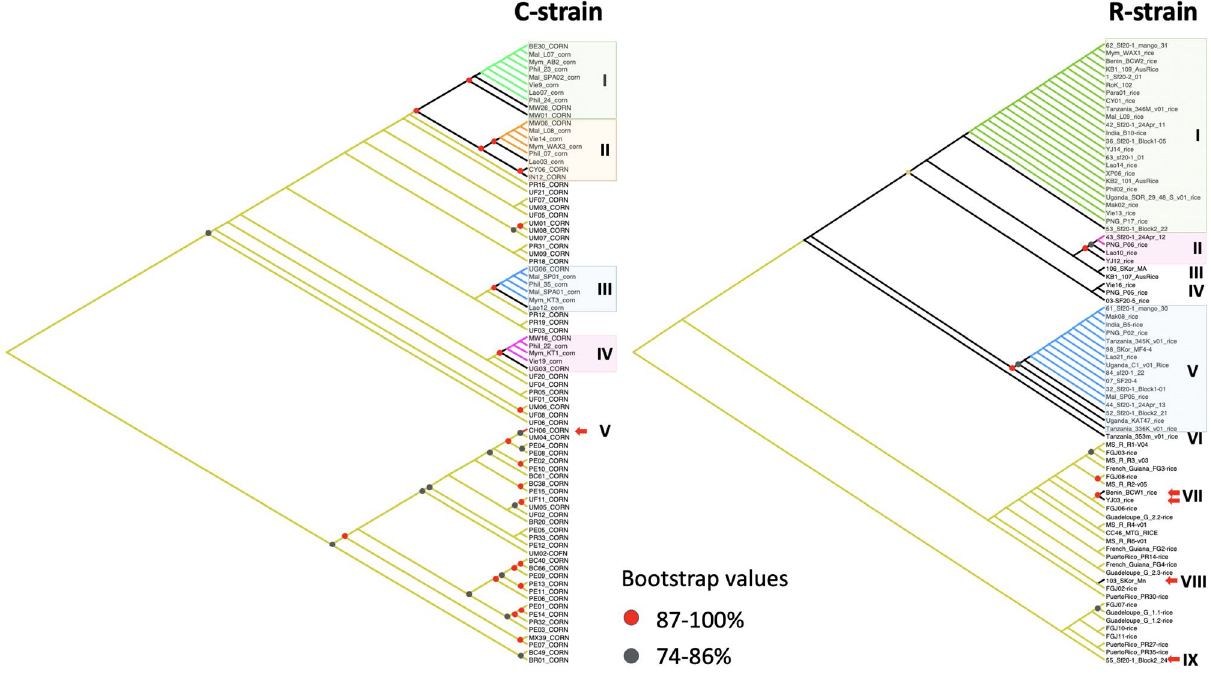
Figure 1. Maximum Likelihood cladograms of unique Spodoptera frugiperda C-strain and R-strain partial mitochondrial genomes based on concatenation of the 13 PCGs (11,393 bp) using IQ-Tree with 1000 UFBoot replications. Individuals in clades I, II, III, and IV (C-strain) and in Clades I, II, V (R-strain) that are in the same colour scheme (i.e., green, orange, blue, or pinks) shared 100% nucleotide identity. Mitogenome haplotypes from native individuals for both C- and R-strains are in khaki green colour. Red and dark grey dots at branch nodes represent bootstrap values of 87–100% and 74–86%, respectively. Bootstrap values < 74% are not shown. Red arrows indicate invasive individuals’ mitogenome haplotypes that are nested within native individuals. Country and sample codes are listed in Tables S1 and